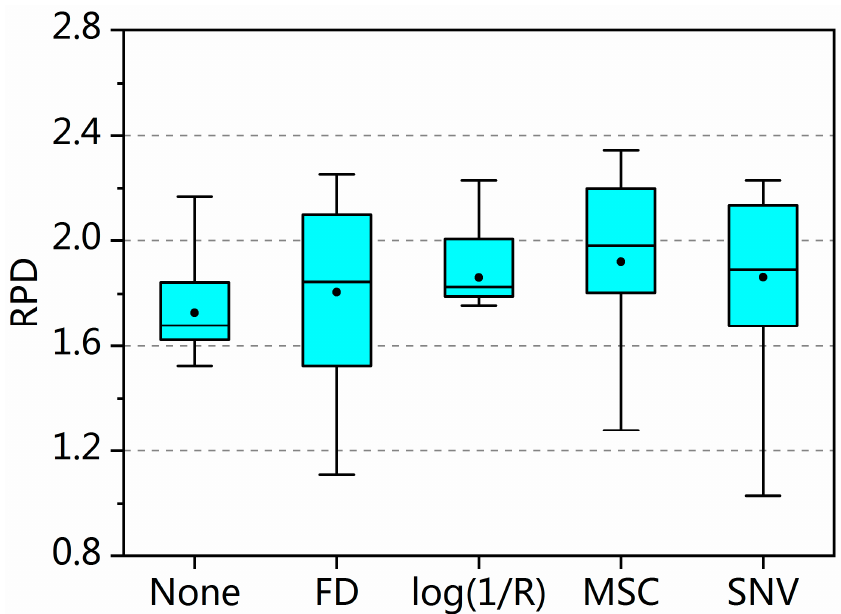
Figure 4. The results of the proportion of calibration sets when pretreatment influenced sample selection positively (dark gray bar) or negatively (light gray bar) and the average ∆RPD (black bar). SG denotes Savitzky–Golay smoothing. FD denotes first derivative. MC denotes mean centering. log(1/R) denotes logarithmic function. MSC denotes multiplicative scatter correction. SNV denotes standard normal variate.